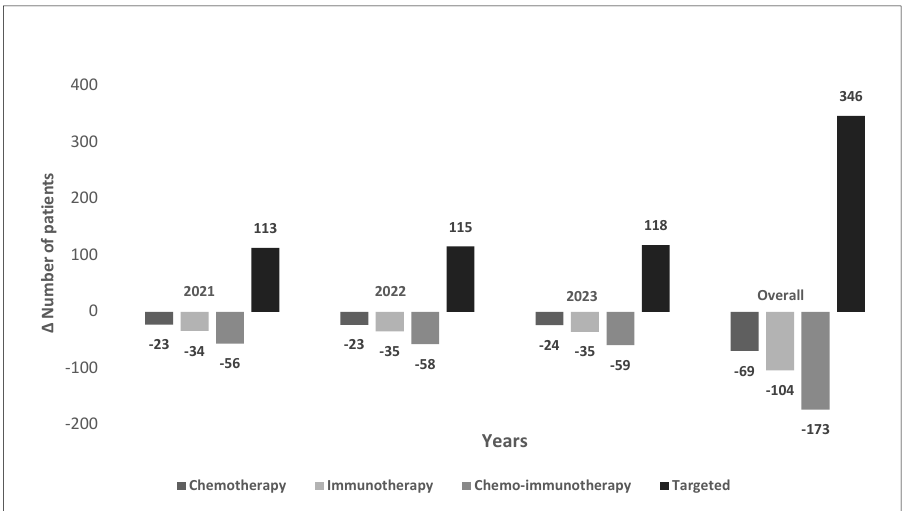
Figure 6. Change in the number of patients moving from non-targeted to targeted therapies.